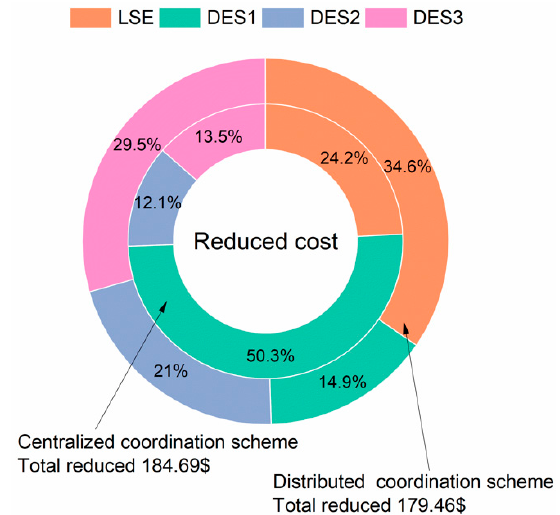
Figure 5. Optimal reduced cost allocation strategy in two schemes.